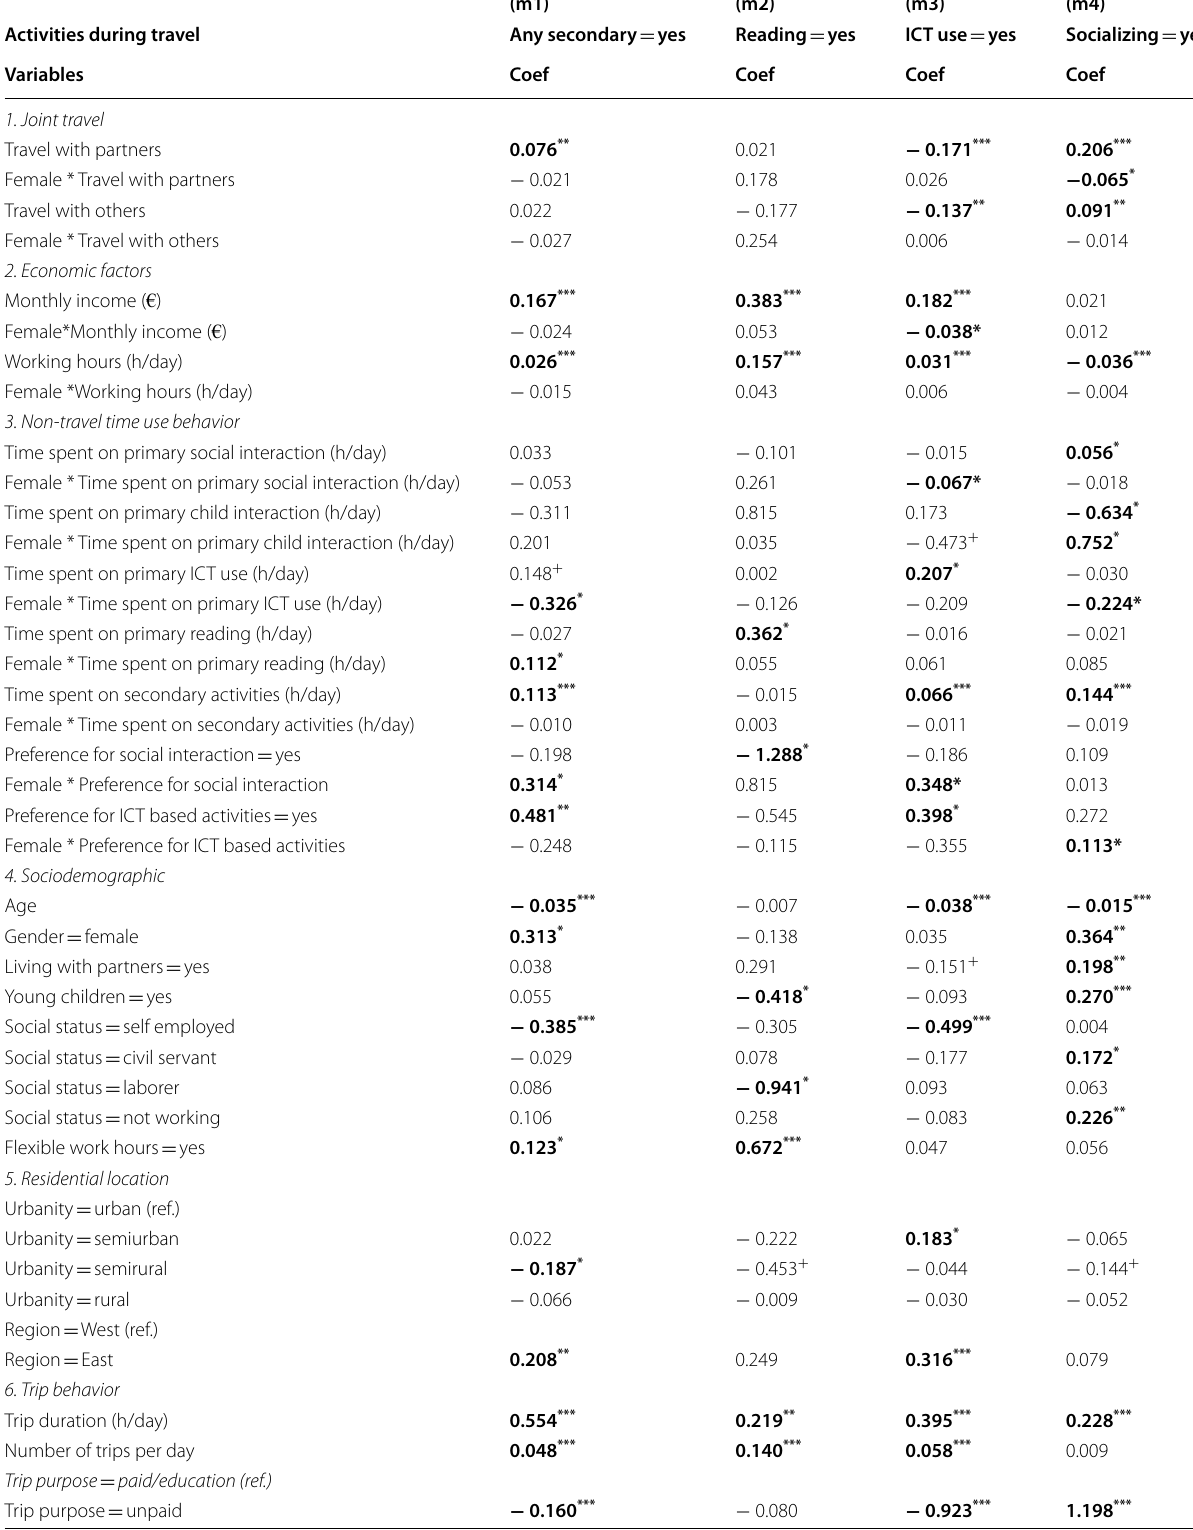
Table 3 Multilevel mixed logistics regression analysis for travel time use